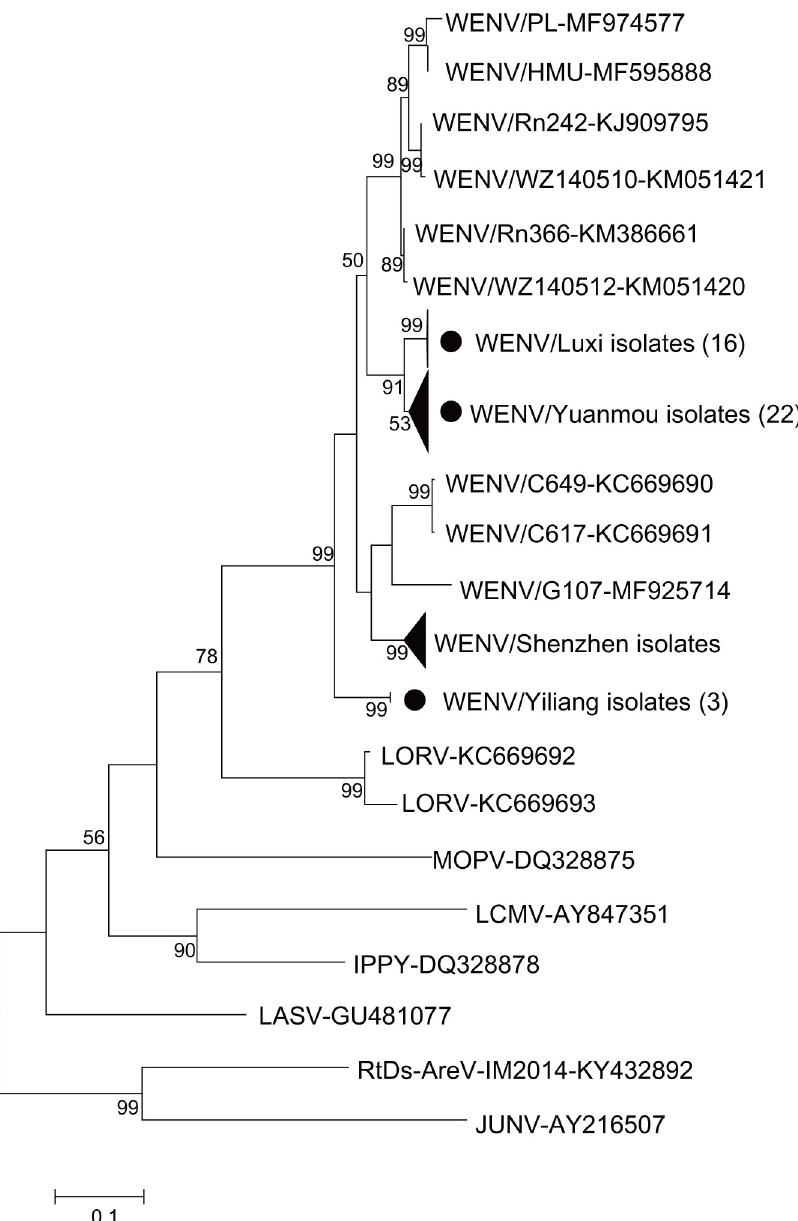
Fig 2. The phylogenetic tree based on partial RdRp sequences detected. The neighbor-joining tree was based on 600 nt L segment sequences and constructed using MEGA 7 software. Bootstrap values were 1,000. The scale bar indicates nucleotide substitutions per site. New sequences obtained in this study are indicated with black circles and the number in the brackets represents positive sequence numbers.